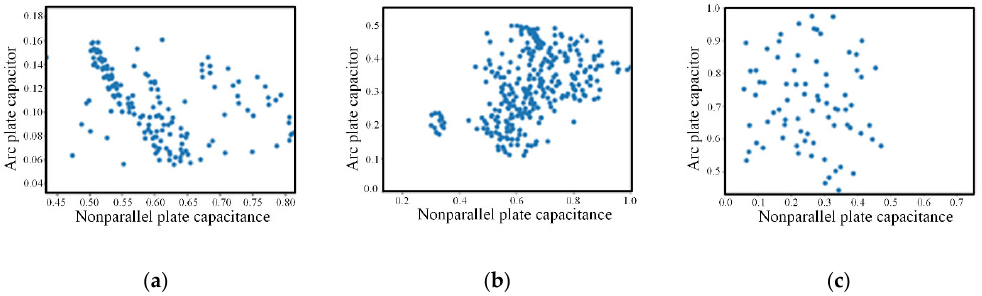
Figure 12. Three different types of wear capacitance data after pretreatment. ( a ) cutting; ( b ) rolling; ( c ) sliding.